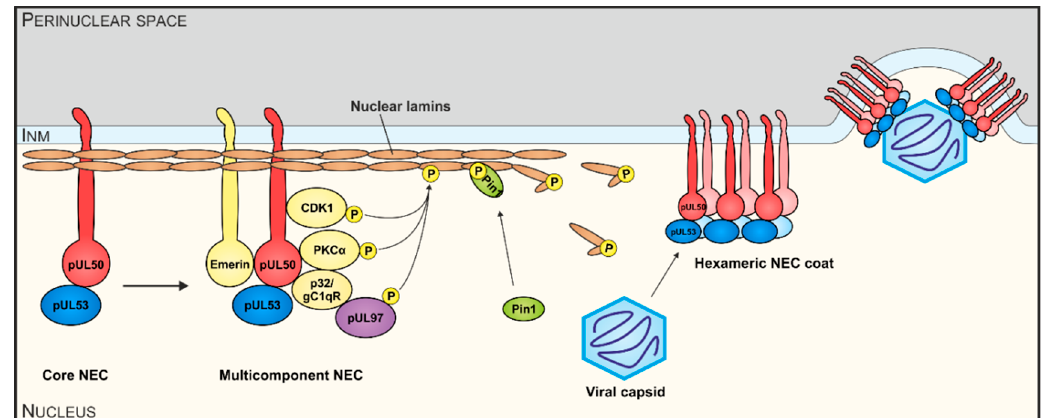
Figure 1. Schematic illustration of functional aspects of human cytomegalovirus (HCMV) nuclear egress complex (NEC) interactions. The HCMV core NEC and multicomponent NEC provide the basis for nuclear lamina as well as membrane-rearranging functions and the formation of a hexameric NEC coat serves as a platform for capsid docking. Viral and cellular protein kinases (pUL97, PKC α , CDK1, others) represent important active components by phosphorylating nuclear lamins A / C, core NEC protein pUL50 and possibly additional NEC constituents.